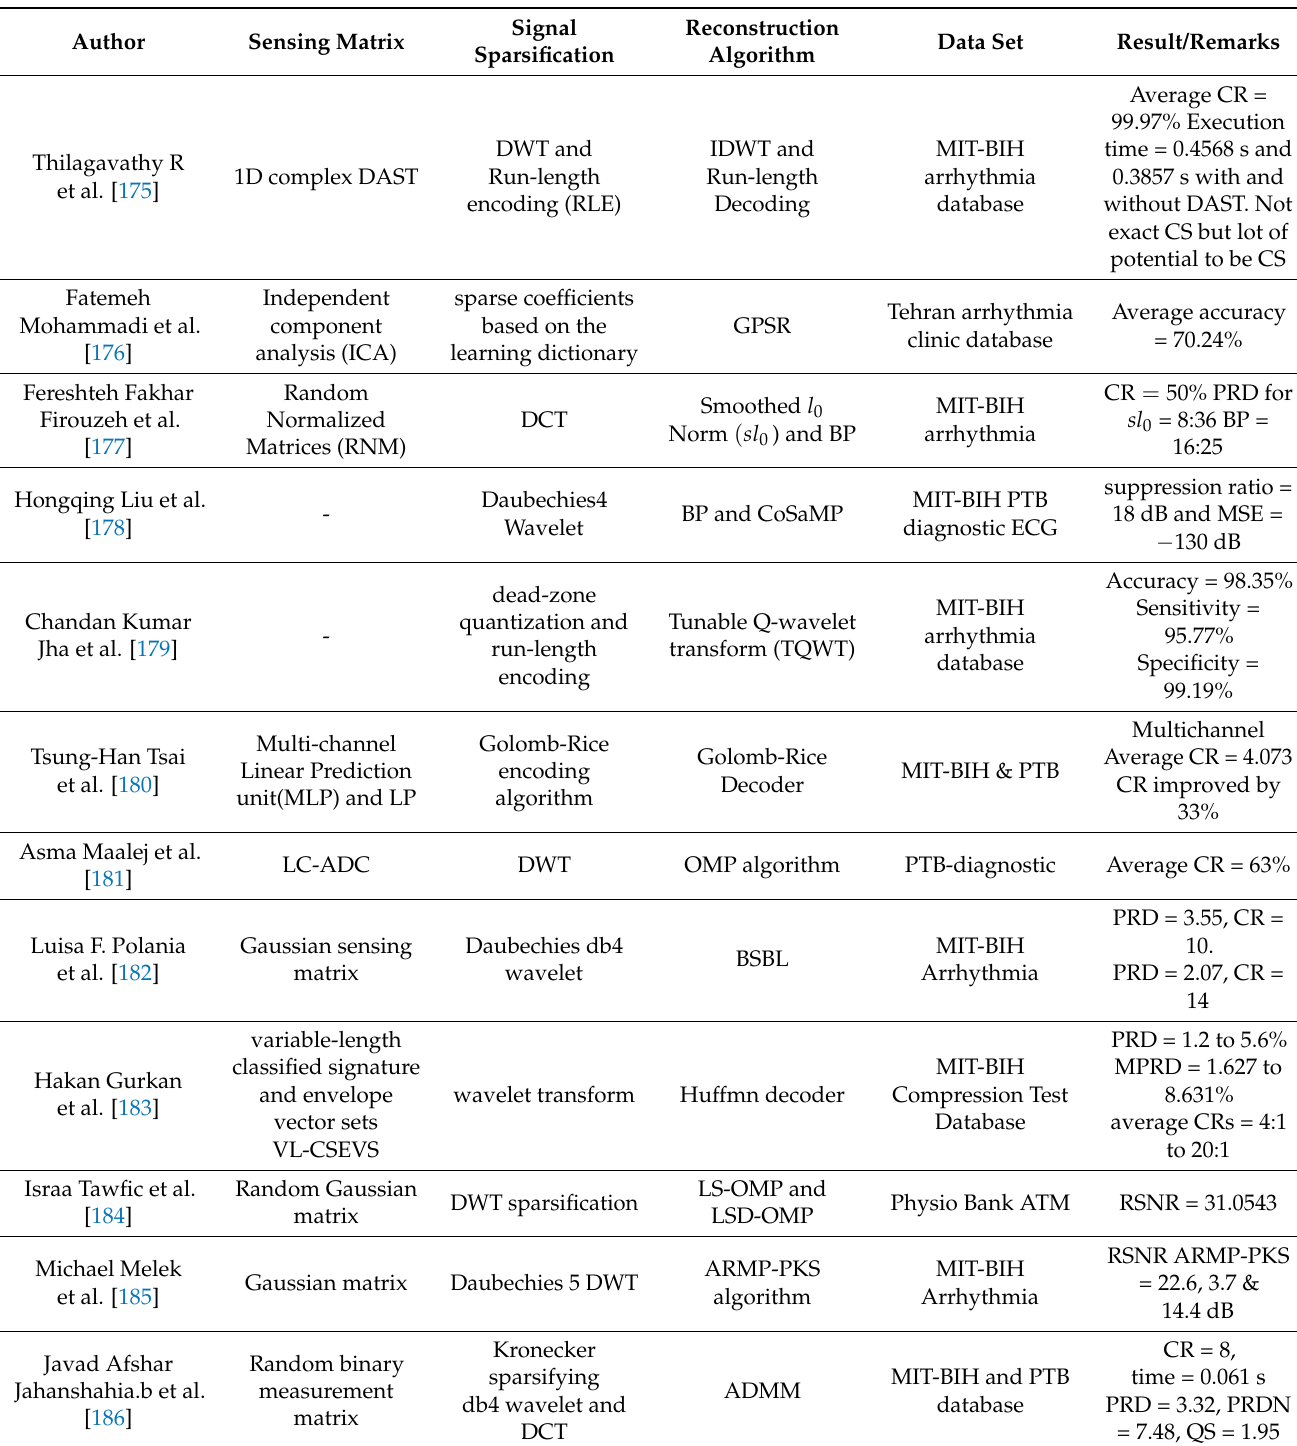
Table 2. CS Models and the Reconstruction algorithm. Note: when a quantifiable data is not available it is marked as -